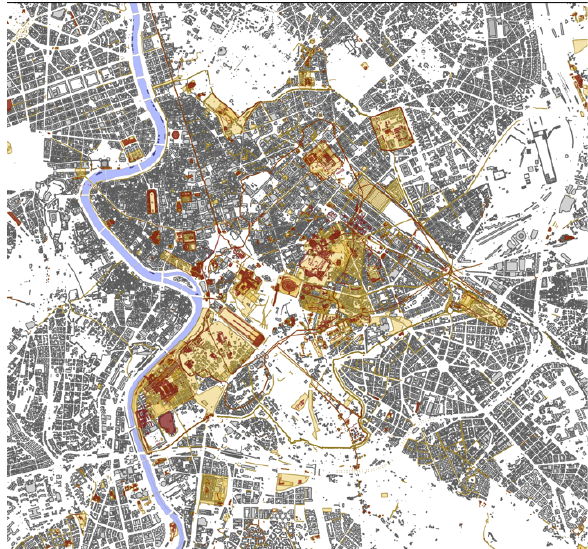
Figure 01 . Traces of the Roman republican and imperial archeology superimposed on the fabric of the contemporary city. The figure is obtained through the use of a WEBGIS platform. (source ARCHEOSITAR PROJECT-